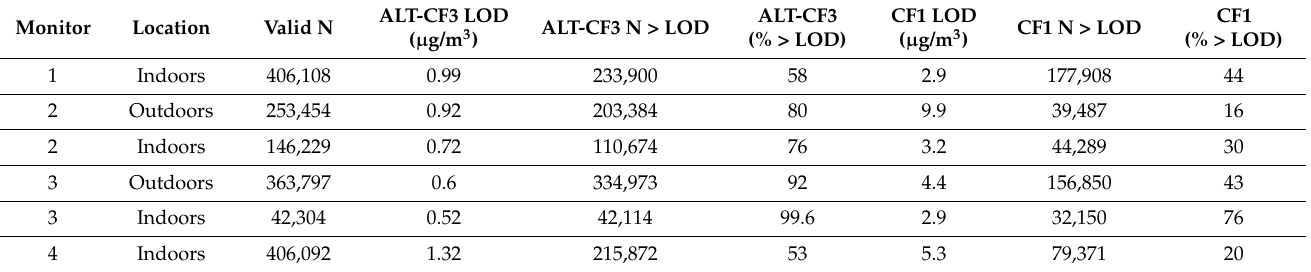
Table 4. LODs and percentage of observations exceeding the LOD for Oakmont comparing the ALT-CF3 algorithm to the Plantower CF1